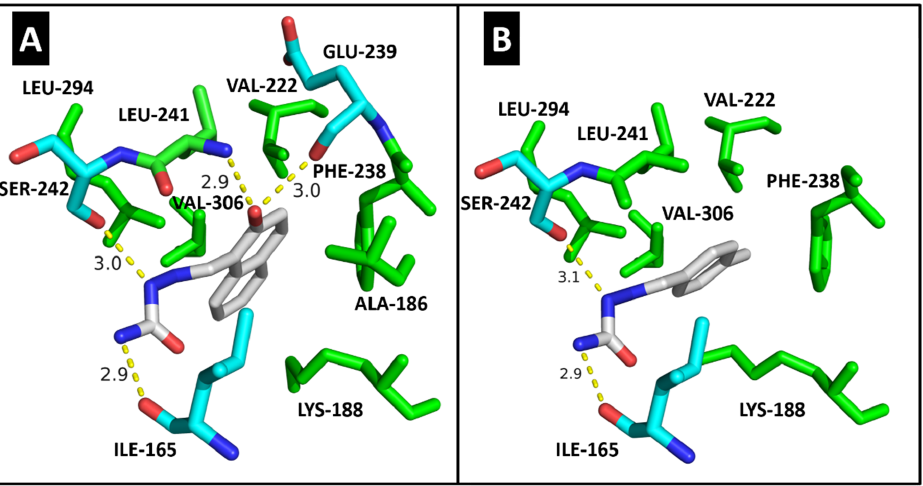
Figure 2. Detailed view of the docking pose for ( A ) compound 3c and ( B ) compound 3g , regarding DYRK1A target. Residues involved in hydrophobic interactions (green), hydrogen bonds (colored per element with carbon atoms in cyan) and the involved in both interaction (colored per element with carbon atoms in green) are highlighted.